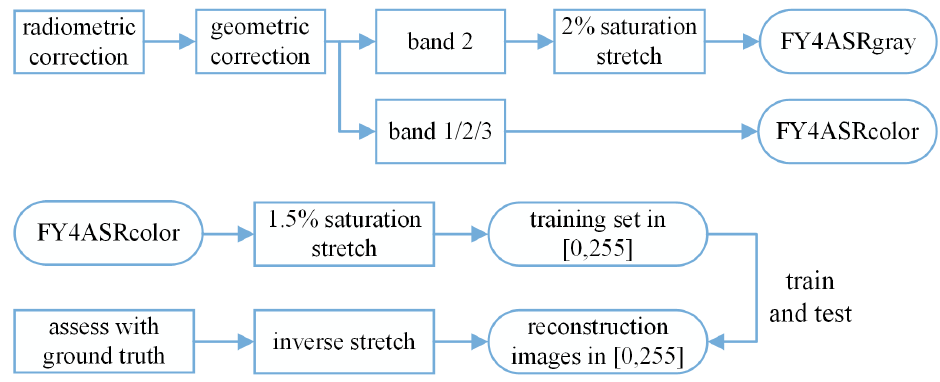
Figure 12. Processing steps for the two